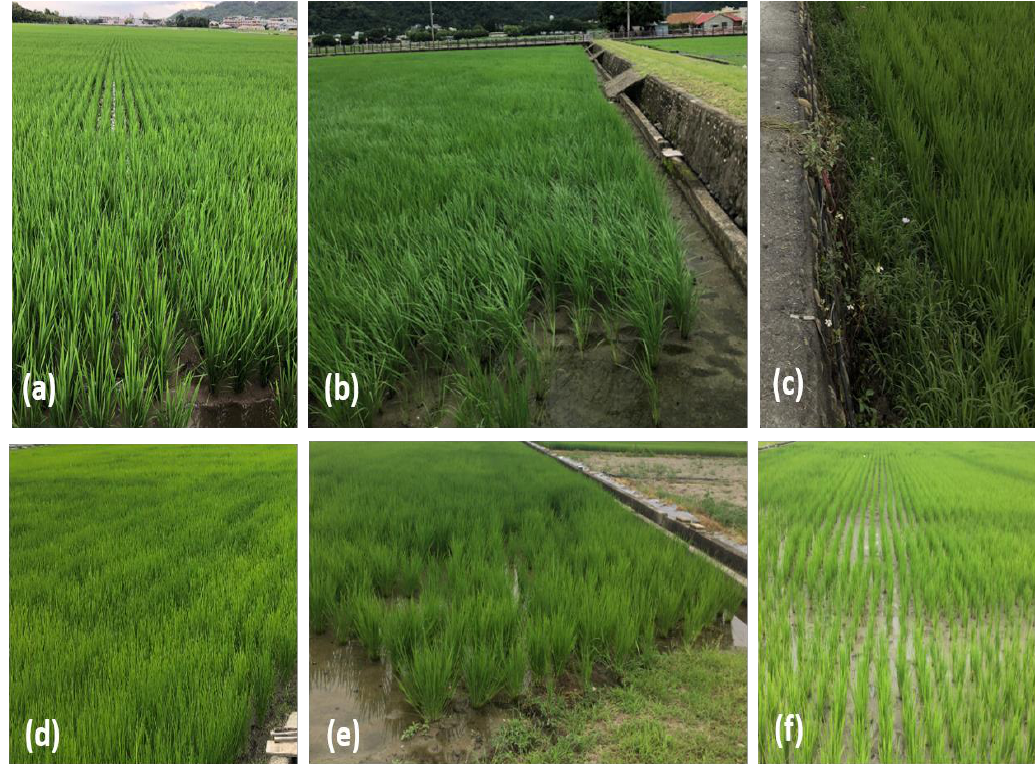
Figure 8. Possible reasons for poor classification: ( a ) different planting directions; ( b ) paddy rice not full; ( c ) weed pixels interference; ( d ) uneven fertilizer application; ( e ) poor growth of machine channels; and ( f ) the growth rate of paddy rice is different.